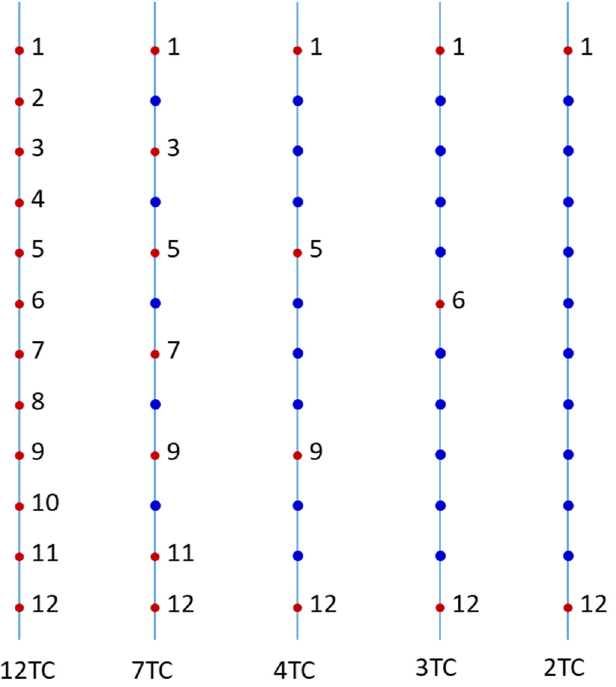
Figure 2. Number and position of the thermocouples used in the 5 models performed for each experimental test to evaluate the sensitivity of the VTC method to the number of TC used. The red circles represent the TC used, and the blue circles represent the positions at which the temperature prediction was made in each model.